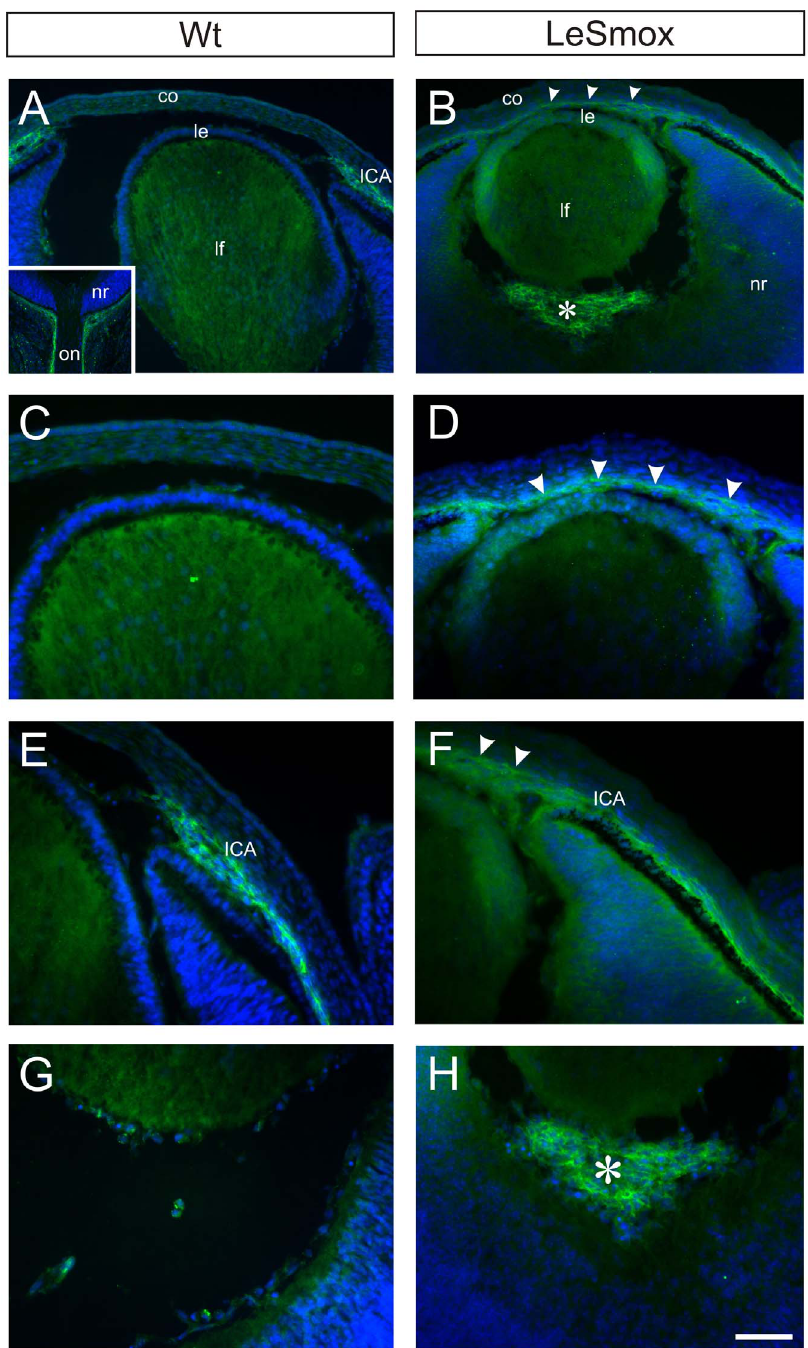
Figure 11. Abnormal migration of Nrp2 + cells in LeSmox eyes. Nrp2 immunofluorescence in frozen sections from Wt ( A, C, E, G ) and LeSmox ( B, D, F, H ) eyes at E14.5. In Wt eyes, Nrp2 + mesenchymal cells are found in the iridial-corneal angle ( A , E; ICA) and lining the external surface of the optic cup and optic nerve (inset, A ), but not in the cornea ( C ) or rarely in the vitreous ( G ). The Wt lens fibres are weakly reactive ( A, C, E ). By contrast, in Le Smox eyes, Nrp2 + mesenchymal cells extend abnormally from the ICA across the inferior layers of the cornea (arrowheads, B , D , F ) and are abundant in abnormal cell clusters (*) in the vitreous ( B , H ). Abbreviations, co, cornea; ICA, iridial-corneal angle; le lens epithelium; lf, lens fibres; nr, neural retina; on, optic nerve. Scale bar, A–B , 100 m m; C–H , 50 m m; inset A, 250 m